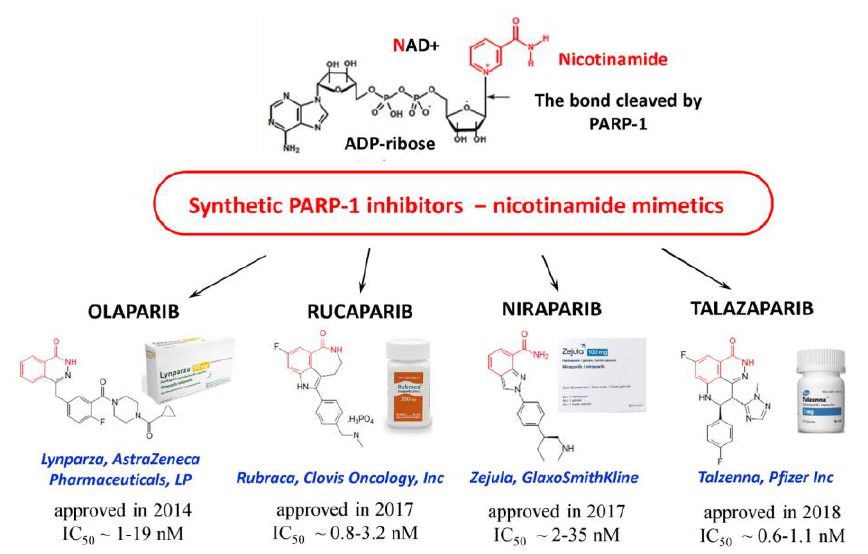
Figure 5. Synthetic PARPi approved for use in oncology. IC50 values (PARPi concentrations inducing 50% inhibition of PARP-1 activity) are cited from [19].